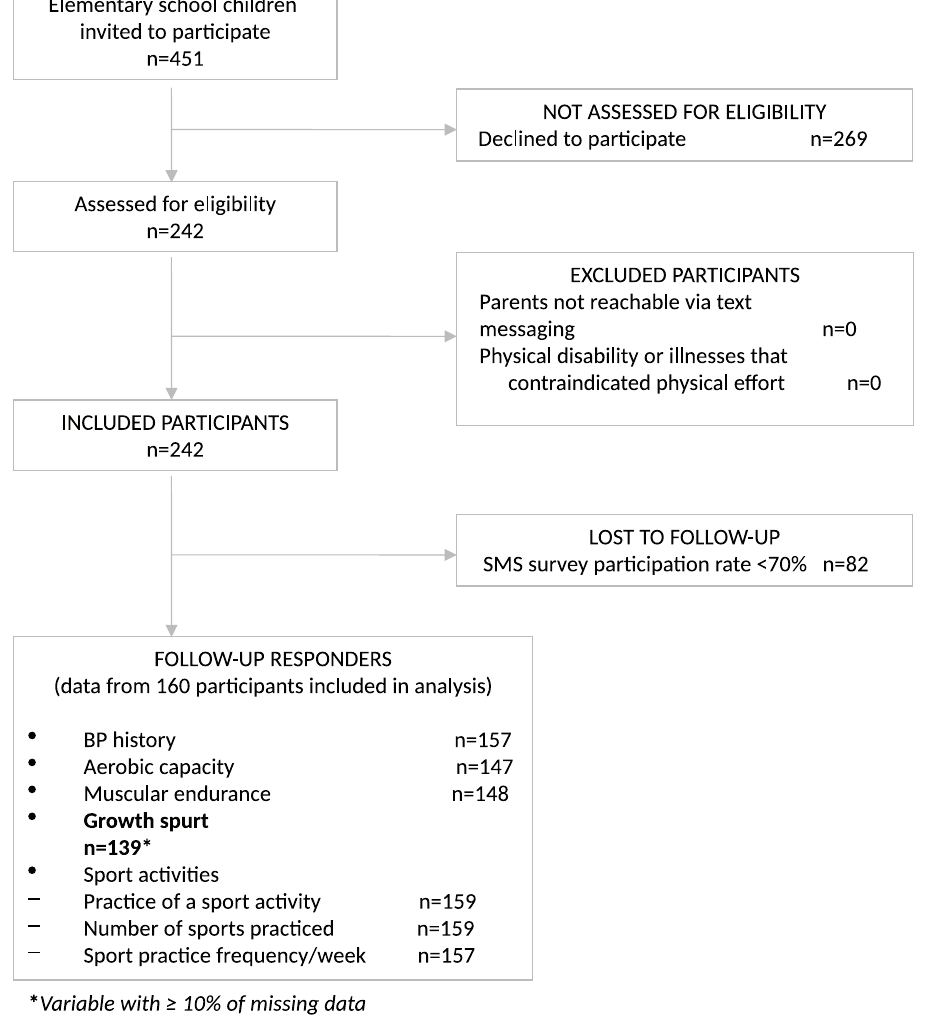
Figure 3. Flowchart of study